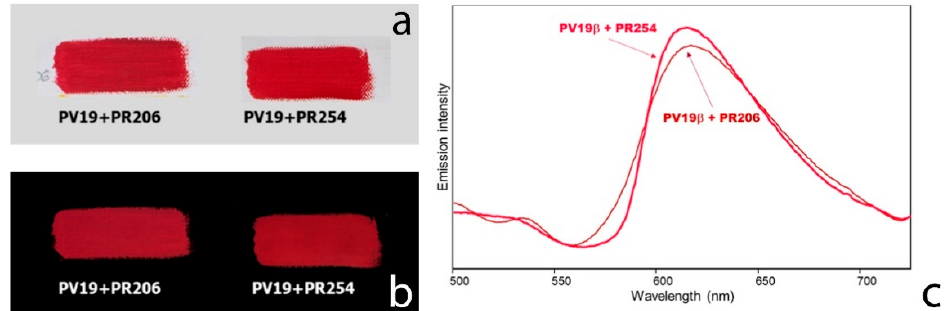
Figure 6. ( a ) Visible image of two samples of commercial oil paints containing respectively a mixture of PV19 and PR206 and a mixture of PV19 and PR254; ( b ) UVF images; ( c ) emission spectra ( λ exc 365 nm) of painting layers shown in ( a ). The maximum intensity value reported in ( c ) is about 1/2 of the highest value in Figure 4.